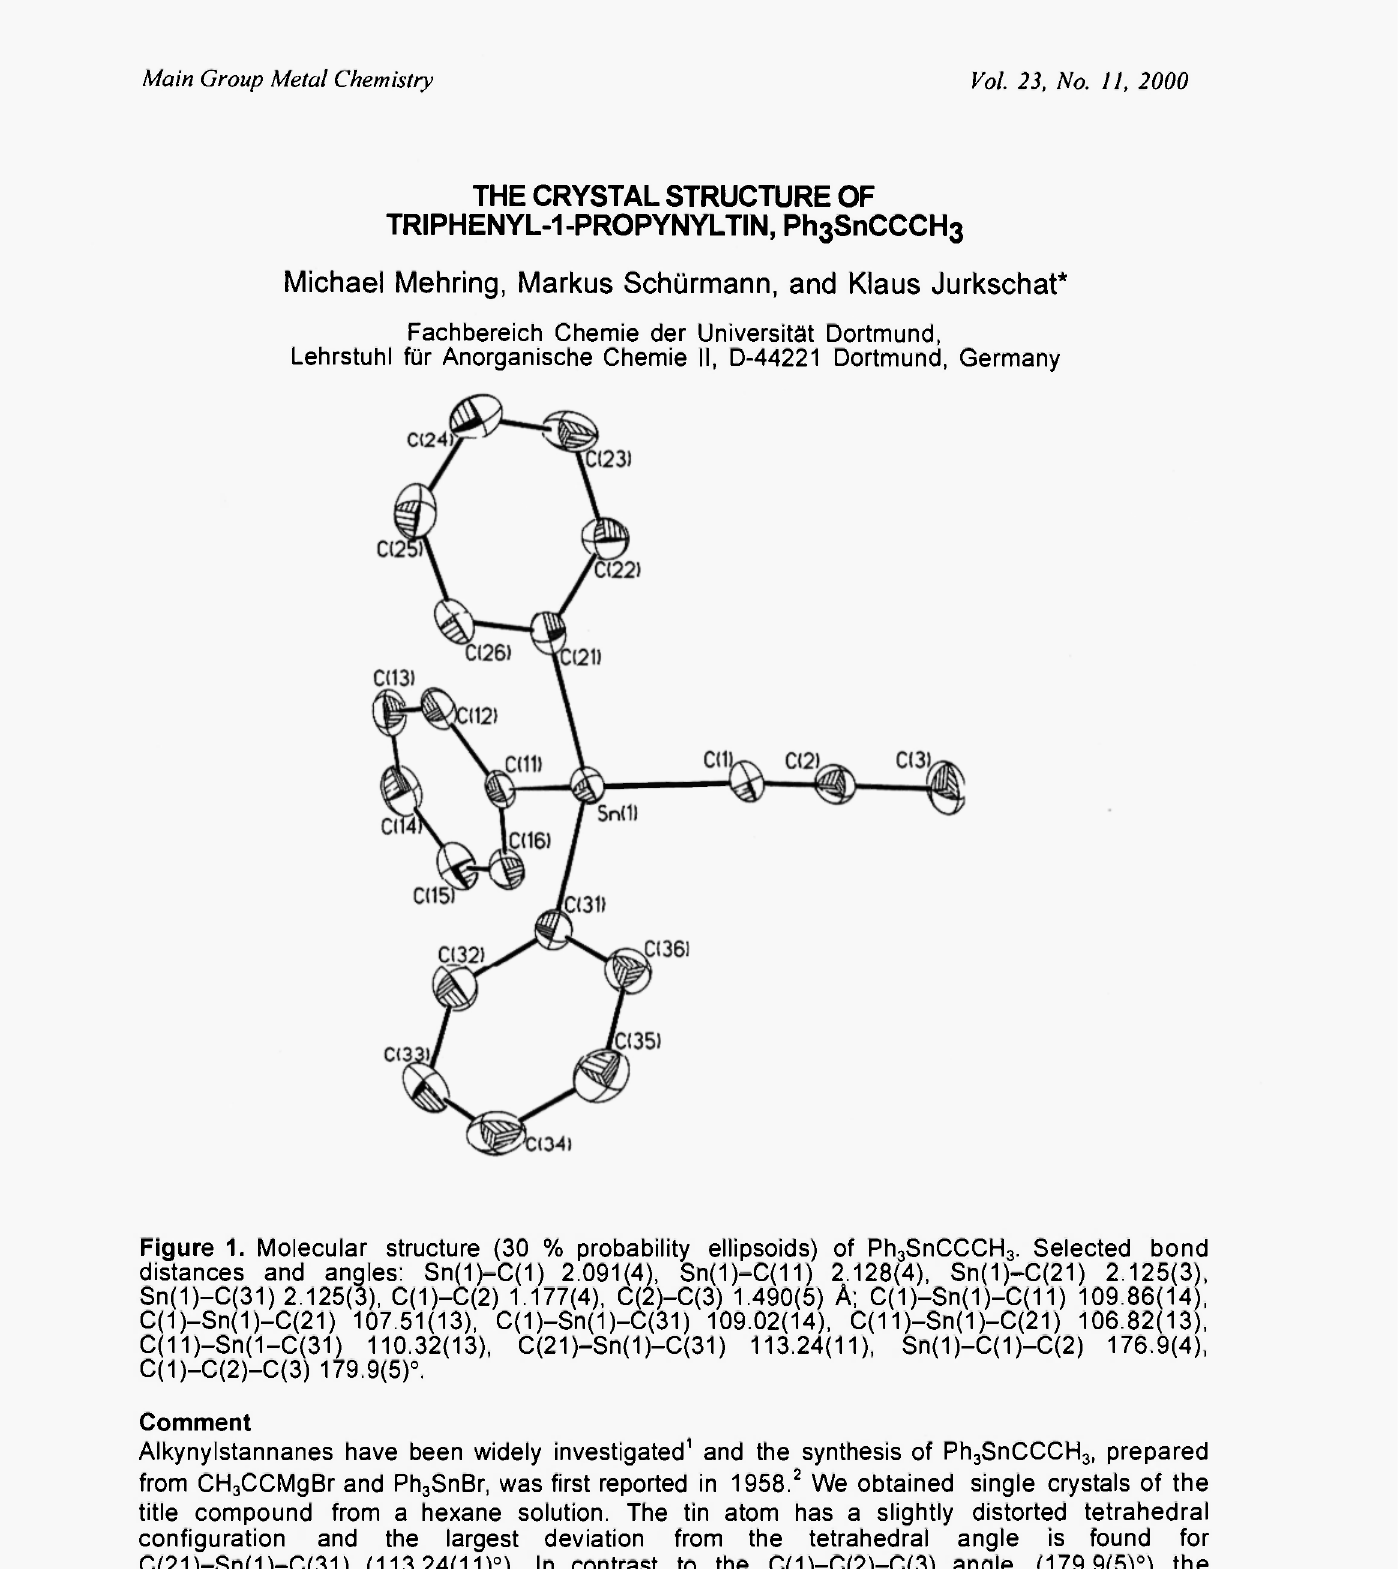
Figure 1. Molecular structure (30 % probability ellipsoids) of Ph 3 SnCCCH 3 . Selected bond distances and angles: Sn(1)-C(1) 2.091(4), Sn(1)-C(11) 2.128(4),